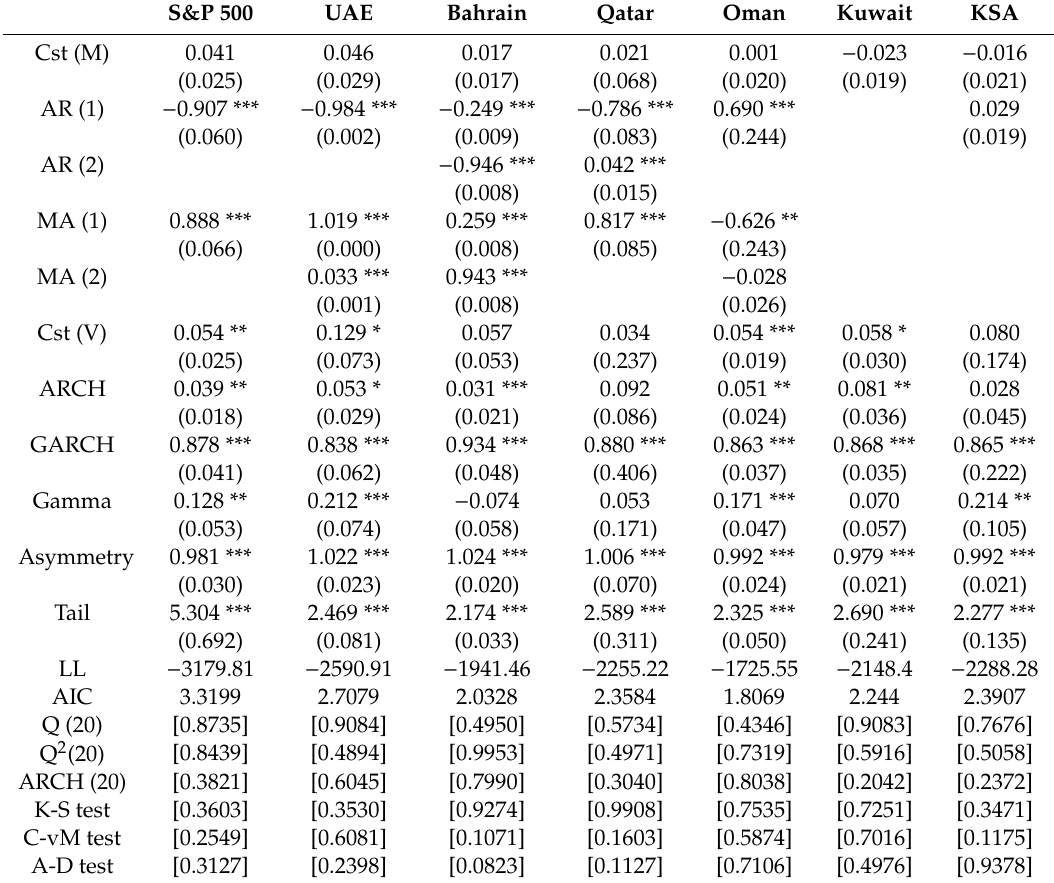
Table 2. Marginal model estimates of the ARMA-GJR (1,1) with skew-t